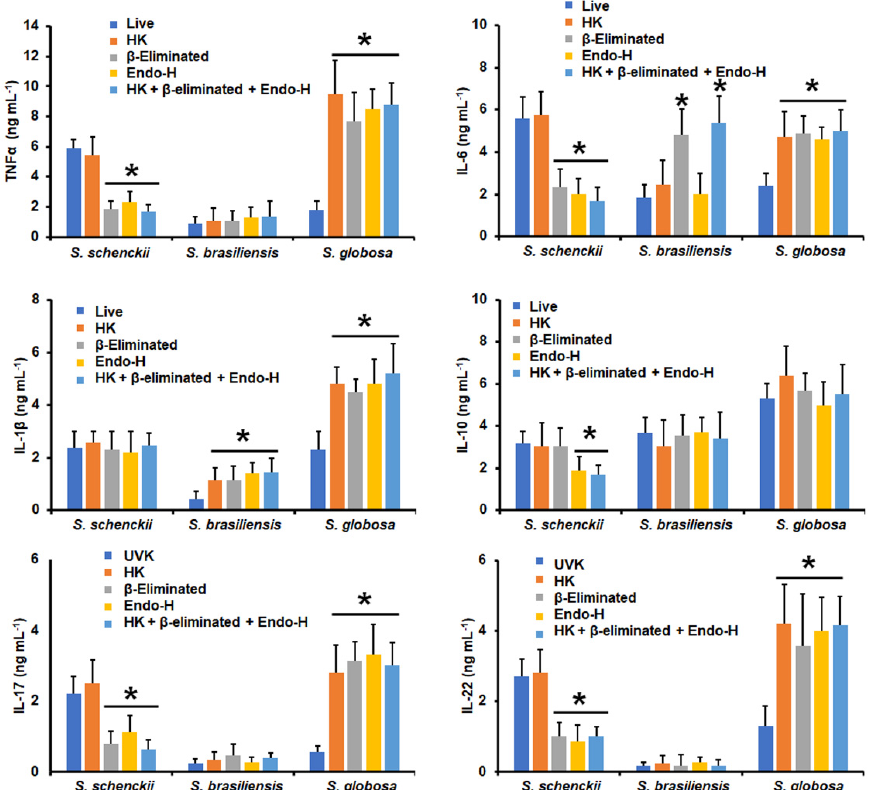
Figure 3. Cytokine production by human peripheral blood mononuclear cells stimulated with conidia from Sporothrix schenckii , Sporothrix brasiliensis , or Sporothrix globosa . For tumor necrosis factor-alpha (TNF α ), interleukin 1 β (IL-1 β ), interleukin 6 (IL-6), and interleukin 10 (IL-10), human peripheral blood mononuclear cells were co-incubated for 24 h with conidia previously subjected to the indicated treatments (see Materials and Methods for details). Alternatively, for interleukin 17 (IL-17) and interleukin 22 (IL-22) stimulation, the human cells were co-incubated with the UV-killed fungal cells or subjected to the indicated treatments. In all cases, the interactions were centrifuged, supernatants collected, and cytokines quanti fi ed by ELISA. UVK—UV-killed cells; HK—heat-killed cells; Endo-H—treatment with endoglycosidase H. Results are the median ± standard deviation from data generated with samples from eight donors, analyzed in duplicate. * p < 0.05 when compared with the cytokine level stimulated by live or UV-killed cells.